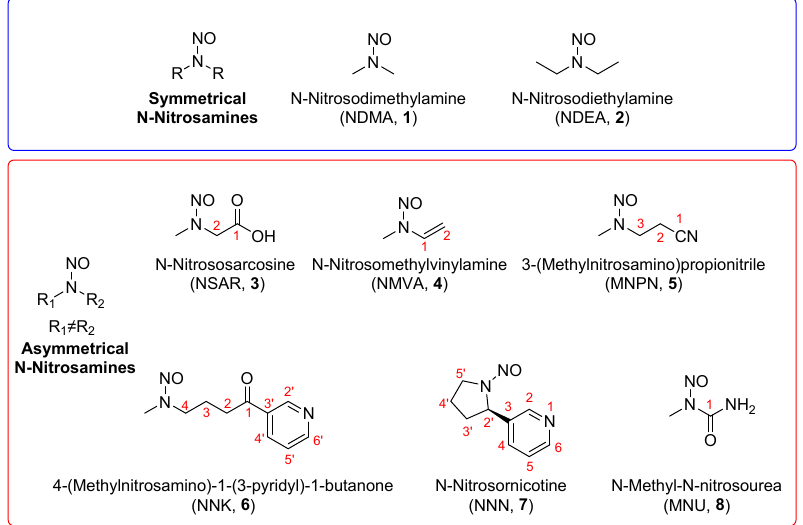
Figure 1. The chemical structures of some N-nitrosamines.